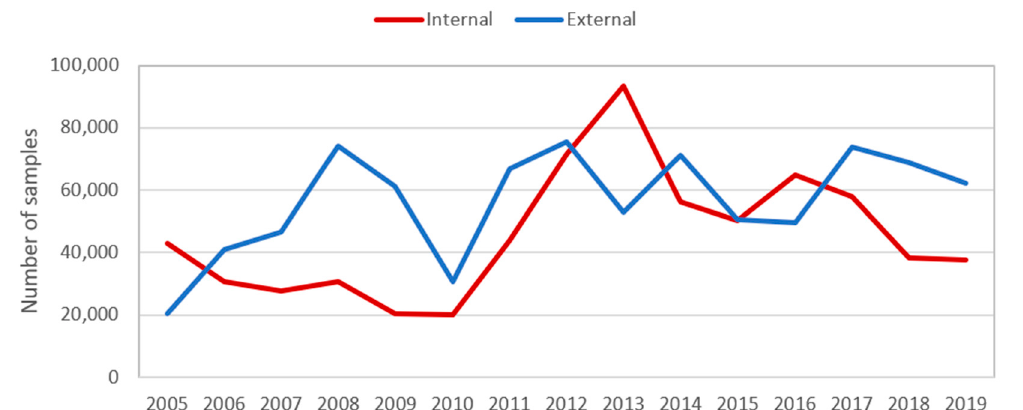
Figure 3. Centers’ distributions, 2010–2019, broken down by (i) transfers within the CGIAR (internal), and (ii) transfers to recipients outside the CGIAR (external).